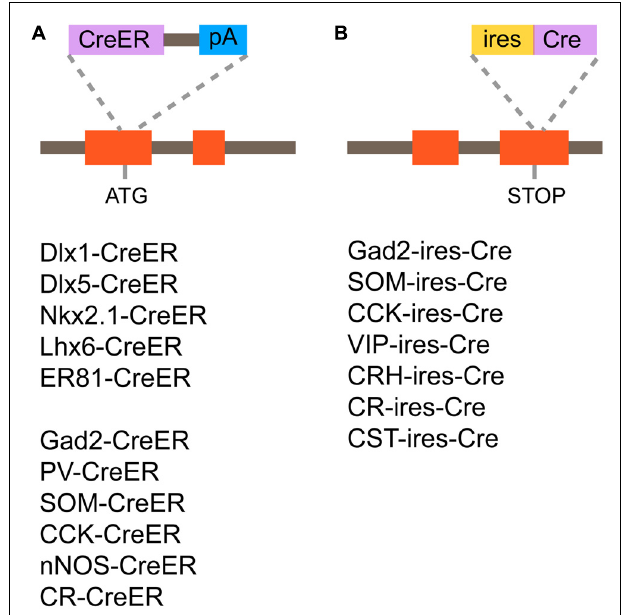
FIGURE 5 | Cre/CreER knockin driver lines targeting GABAergic mature interneurons and progenitors. (A) Design of CreER knockin strategy and list of CreER driver lines. CreER is inserted at the translation initiation codon of the target gene locus. (B) Design of Cre knockin strategy and list of Cre driver lines. Cre is inserted immediately after the translation STOP codon followed by the internal ribosomal entry site (ires) sequence.